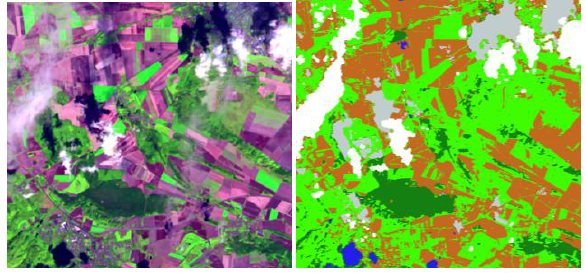
Figure 3. Atmospheric corrected LS-8 scene and land use classification